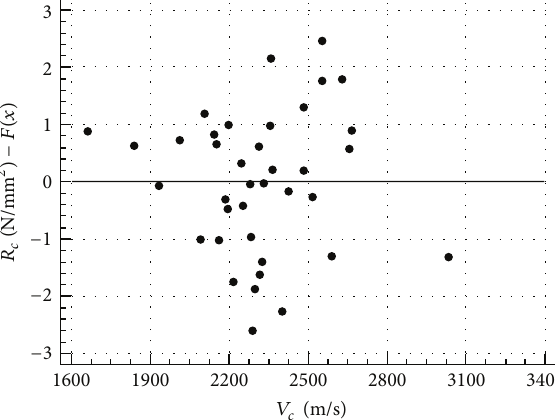
Figure 8: Residuals plot of compressive strength in cubes.